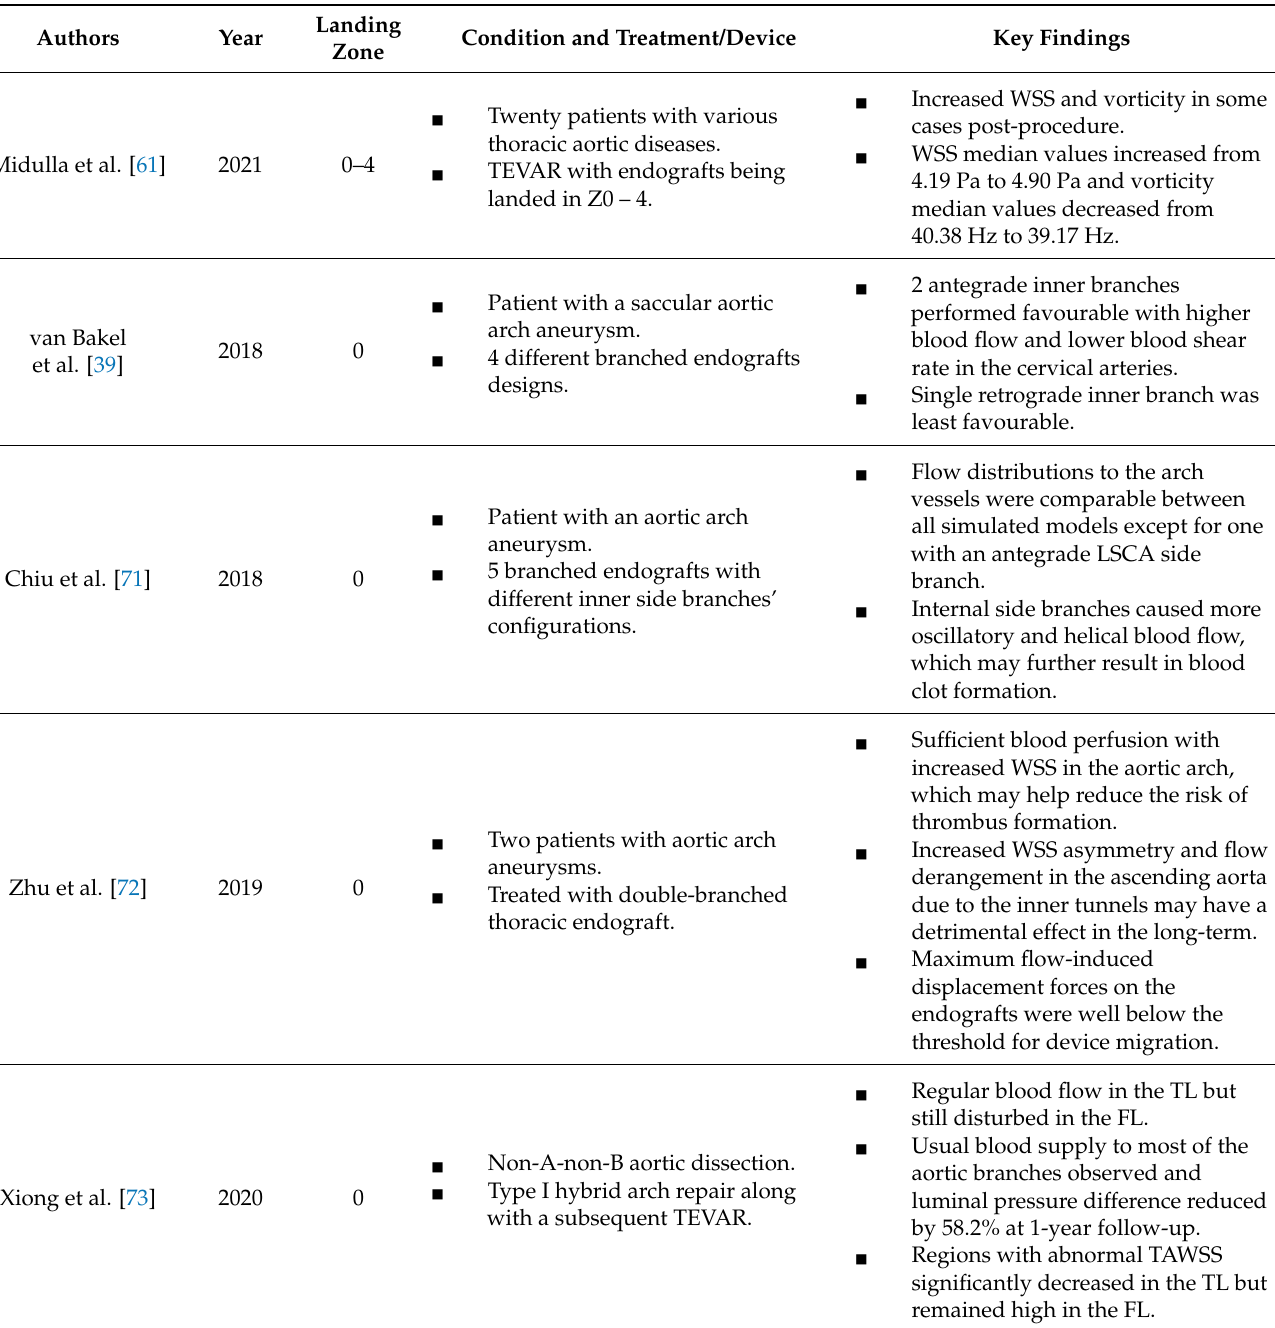
Table 3. A summary of computational studies carried out using patient-specific aortic